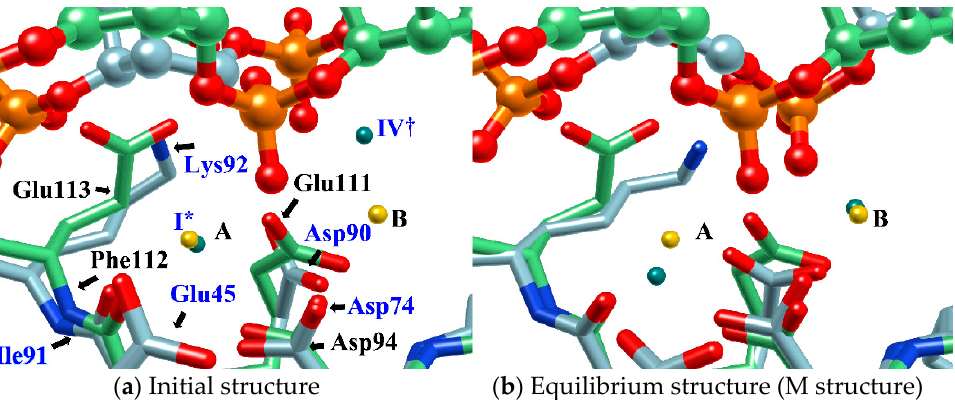
Figure 9. Comparison of ( a ) the MD initial structure and ( b ) the equilibrium structure (M structure) of Eco RV–DNA complex with Bam HI-DNA structure (DNA, ball and stick; protein, stick; Eco RV, green; Bam HI, blue; position of Mg 2+ ion in MD simulation of Eco RV-DNA, green sphere (each label of ions in the initial structure has the same meaning as that in Figure 7); position of Ca 2+ ion in Bam HI-DNA, yellow sphere). [The figure is reprinted from Ref. 69].